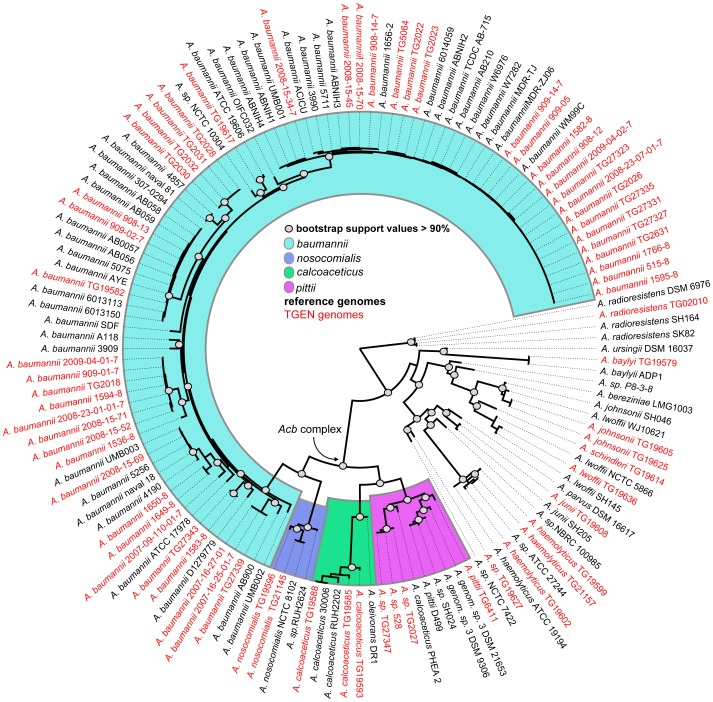
A whole genome phylogeny of 136 sequenced genomes in the genus Acinetobacter.The phylogeny was inferred with FastTree2 [52] on a single nucleotide polymorphism (SNP) matrix alignment calculated with kSNP [50] and filtered with noisy [51]. The phylogeny was rooted with A. radioresistens. Genomes sequenced in the current study are shown in red. Genomes in the Acinetobacter calcoaceticus-baumannii (Acb) complex are colored by clade.